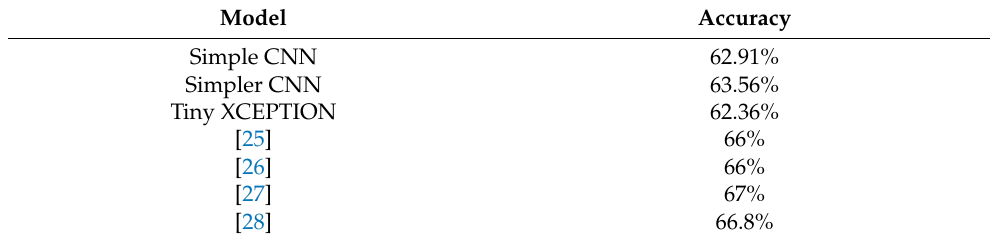
Table 1. Model comparison results.